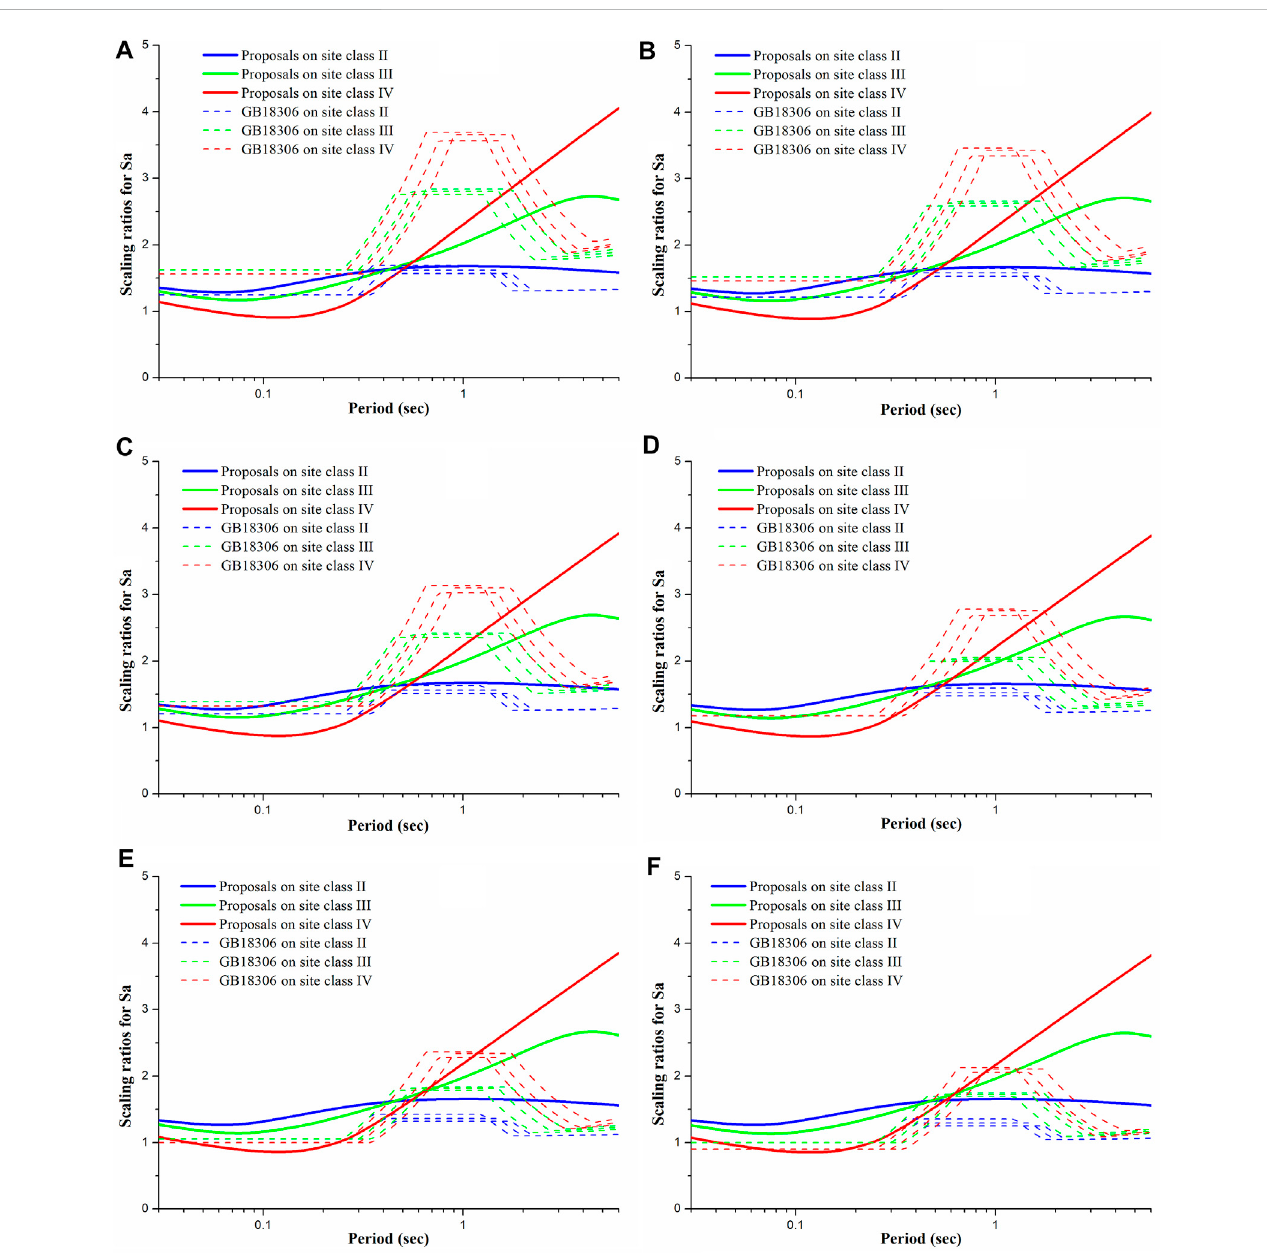
FIGURE 10 Scaling ratios for Sa on site class II, III, and IV when PGA on site class I 1 (A) ≤ .5 m s − 2 , (B) = 1.0 m s − 2 , (C) = 1.5 m s − 2 (D) = 2.0 m s − 2 , (E) = 3.0 m s − 2 , and (F) ≥ 4.0 m s − 2 .